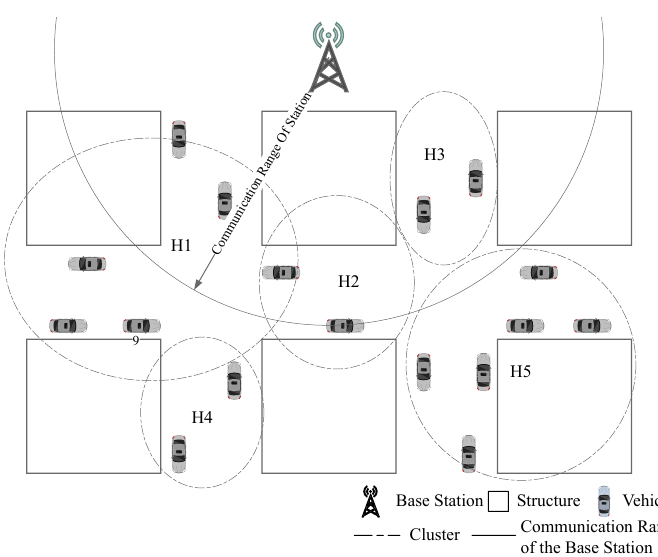
Figure 8. Base Station and Clusters ( H i indicates cluster of vehicles with similar CSI).